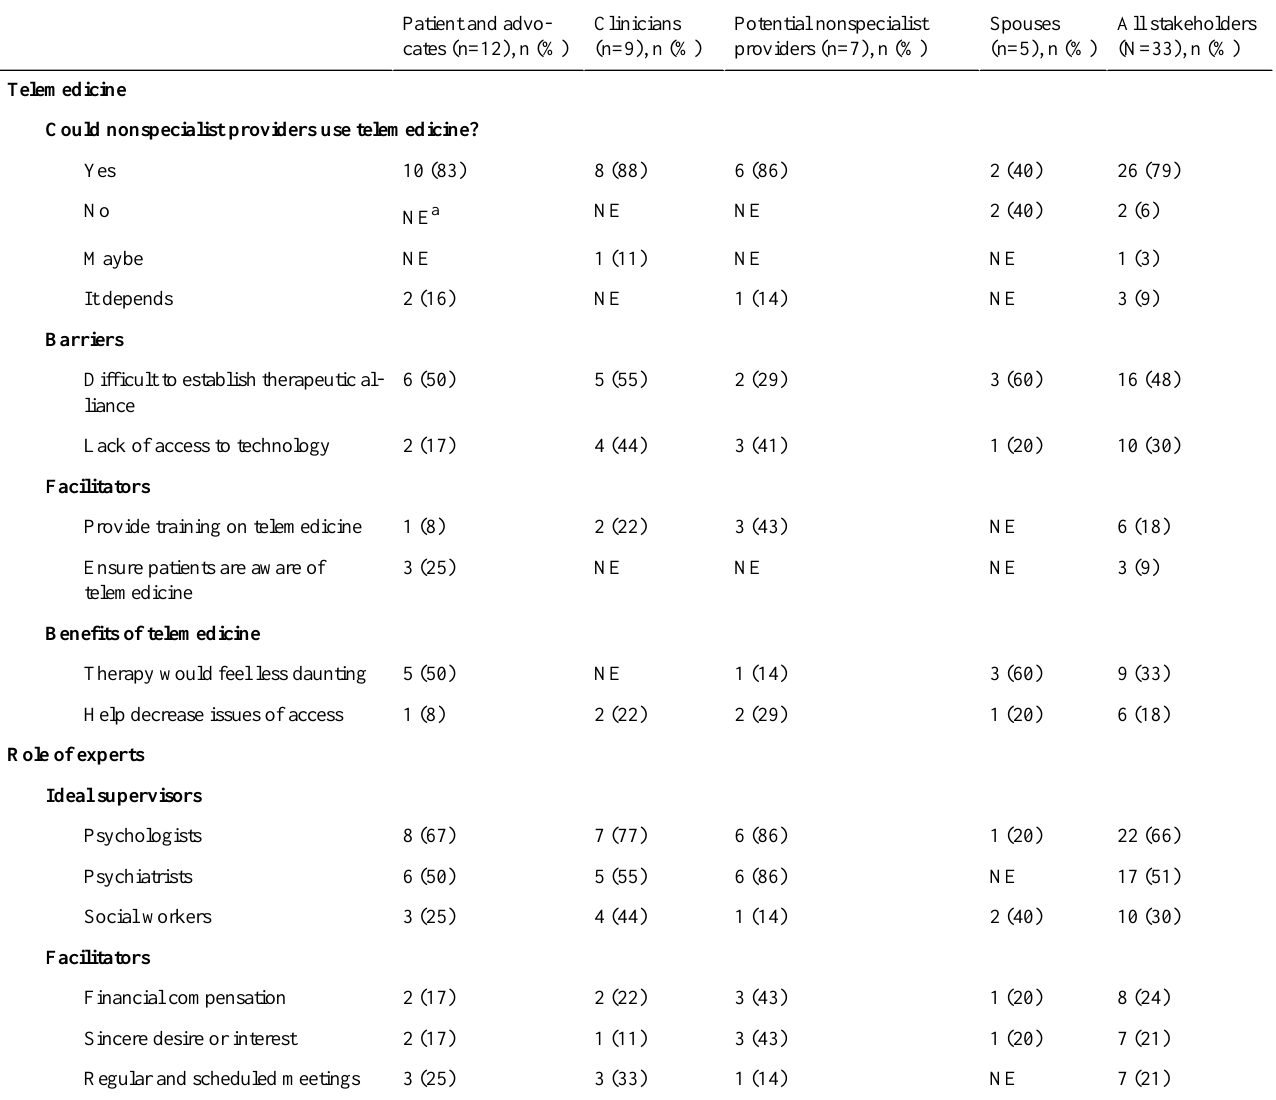
Table 3. Delivering psychological treatments via telemedicine and the role of experts. OverallStakeholder